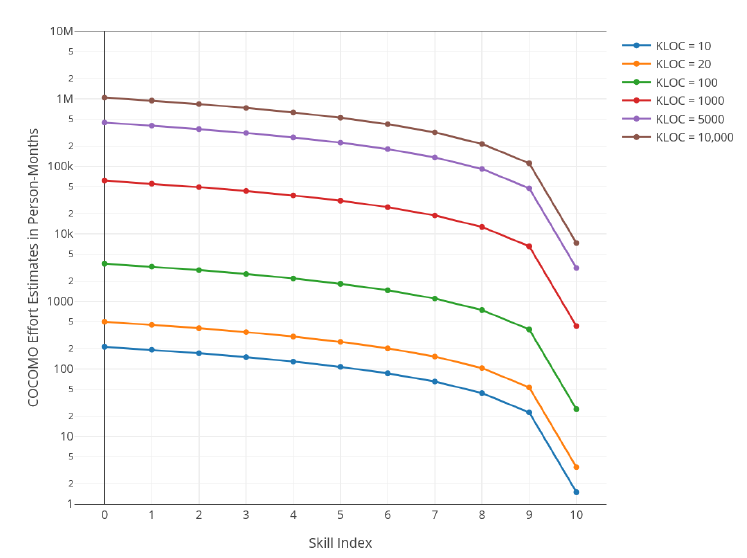
Figure 7. Constructive Cost Model (COCOMO) effort estimation for various program sizes measured in thousands of lines of source code (KLOC).